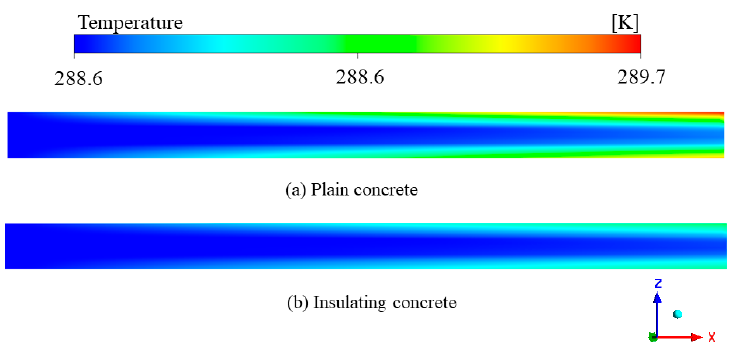
Figure 14. Longitudinal section of wind-flow temperature field: ( a ) Wind flow temperature field of the roadway under normal concrete support; ( b ) Wind flow temperature field of the roadway under insulated concrete support.